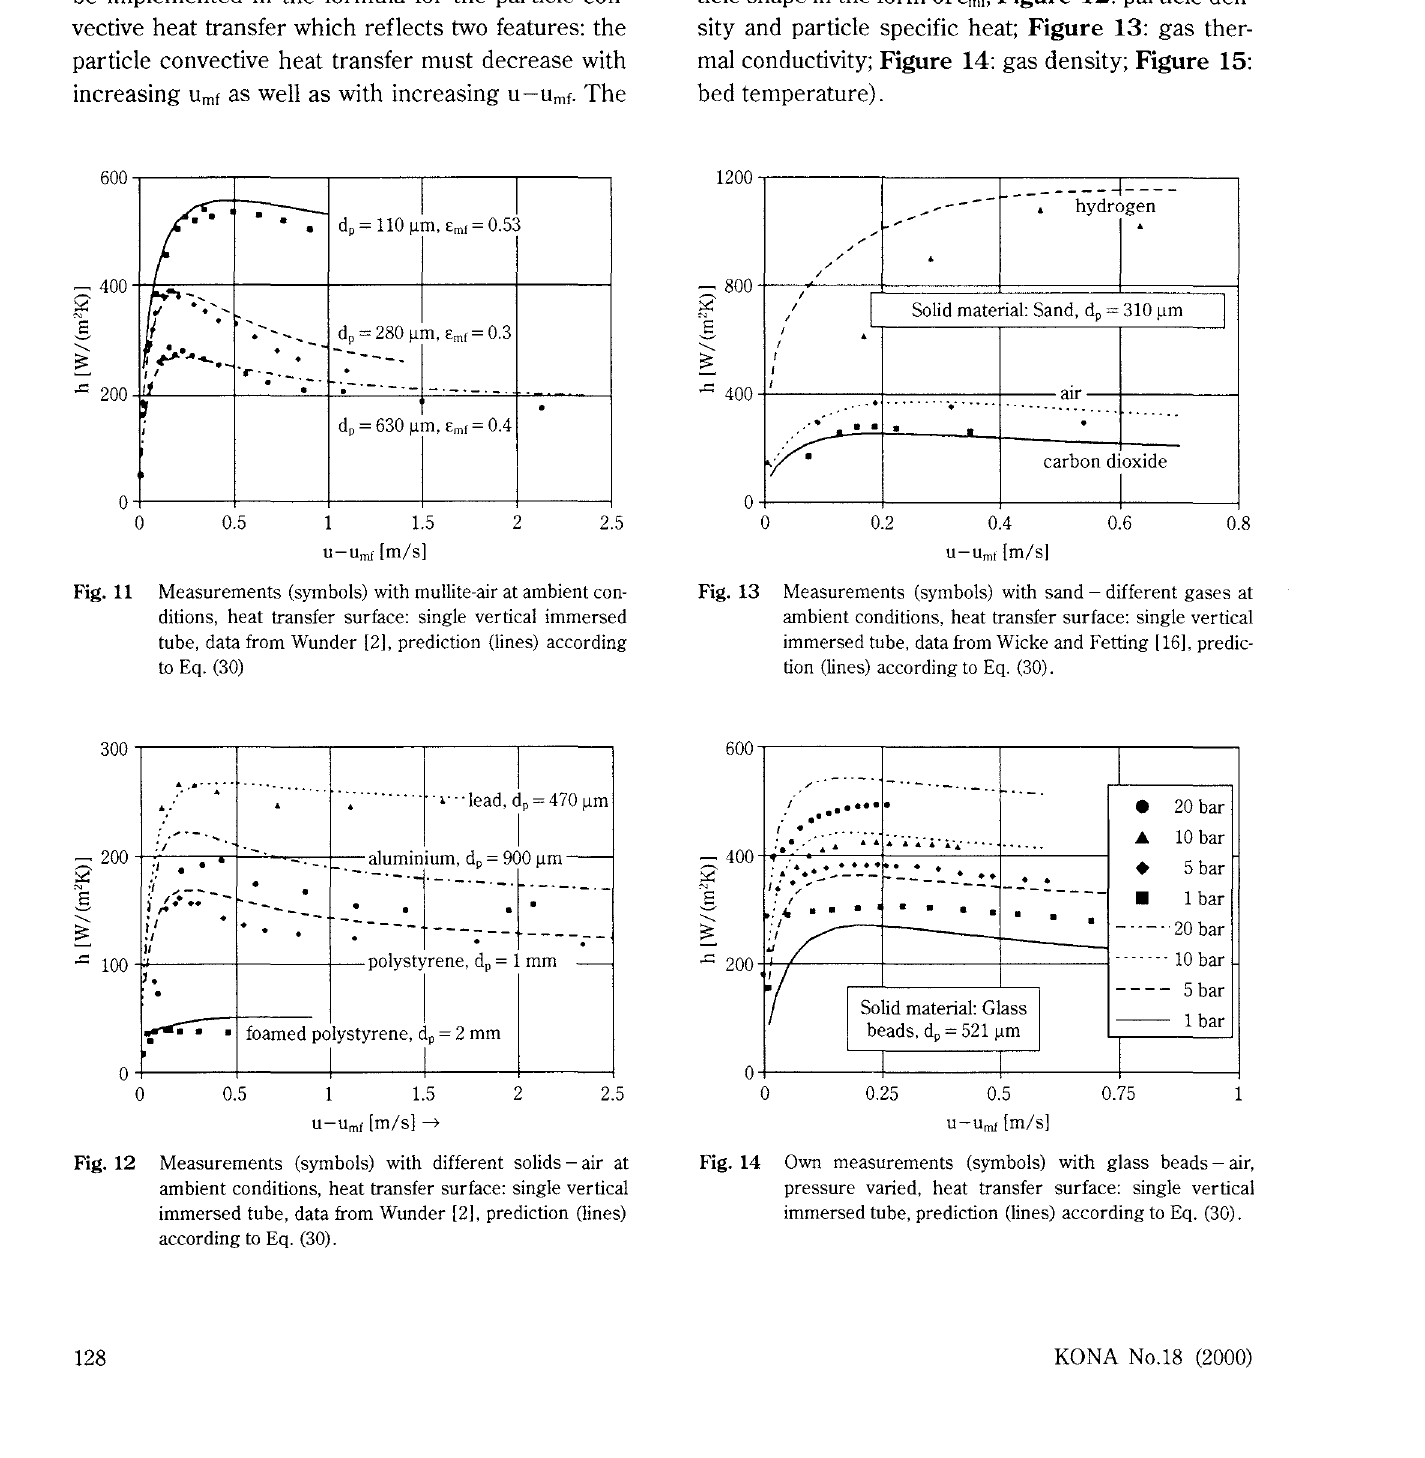
bed temperature).